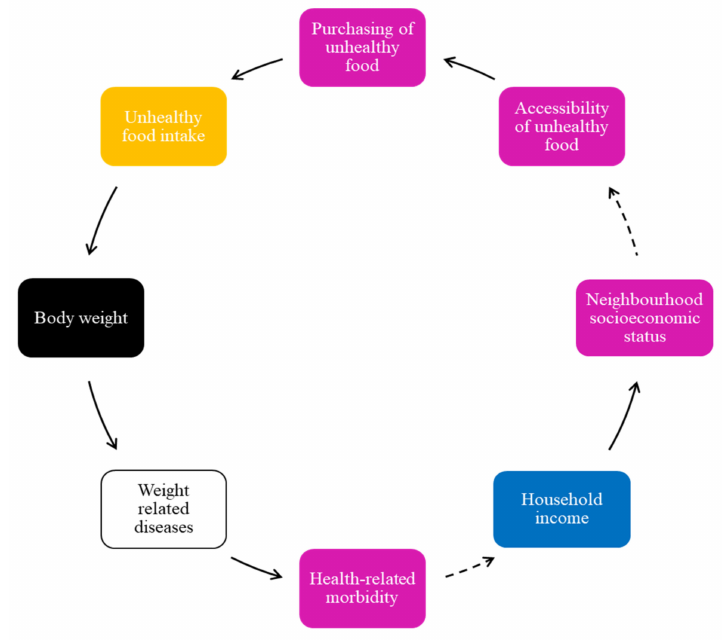
Figure 4. Accessibility of unhealthy food and energy intake/body